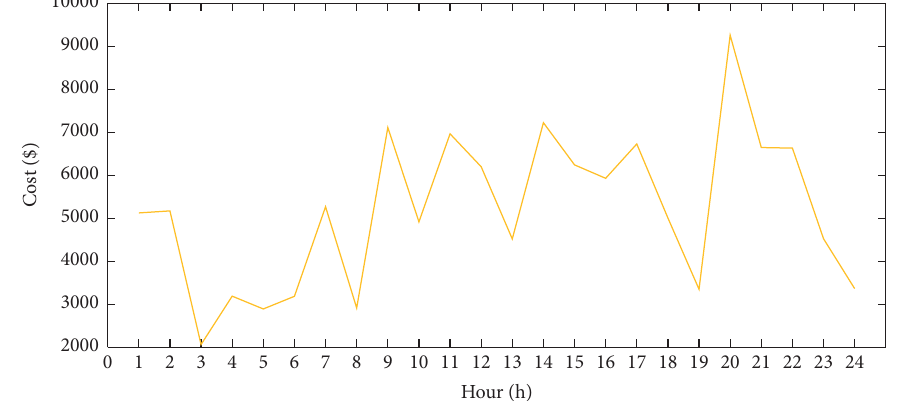
Figure 18: Daily cost of typical day in